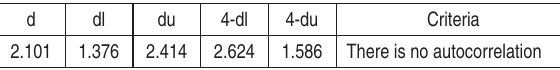
Table 3. Durbin-Watson test